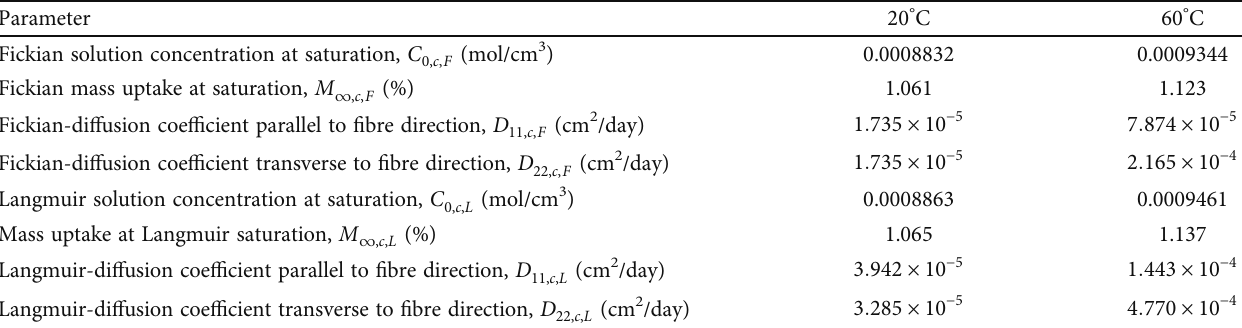
Table 4: CFRP tendon Fickian and Langmuir-di ff usion parameters at 20 ° C and 60 ° C. Parameter Fickian solution concentration at saturation, C 0, (mol/cm 3 c , F